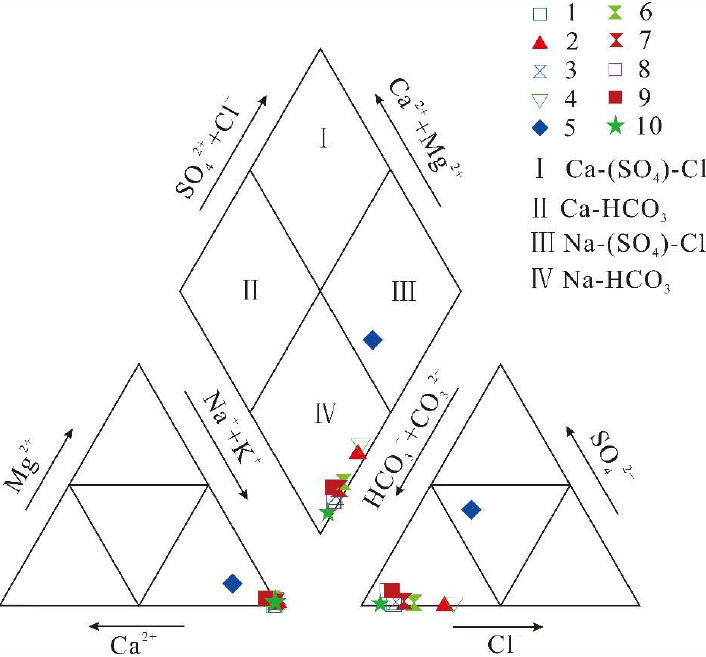
Figure 2. Piper diagram of the ionic compositions of produced water samples.